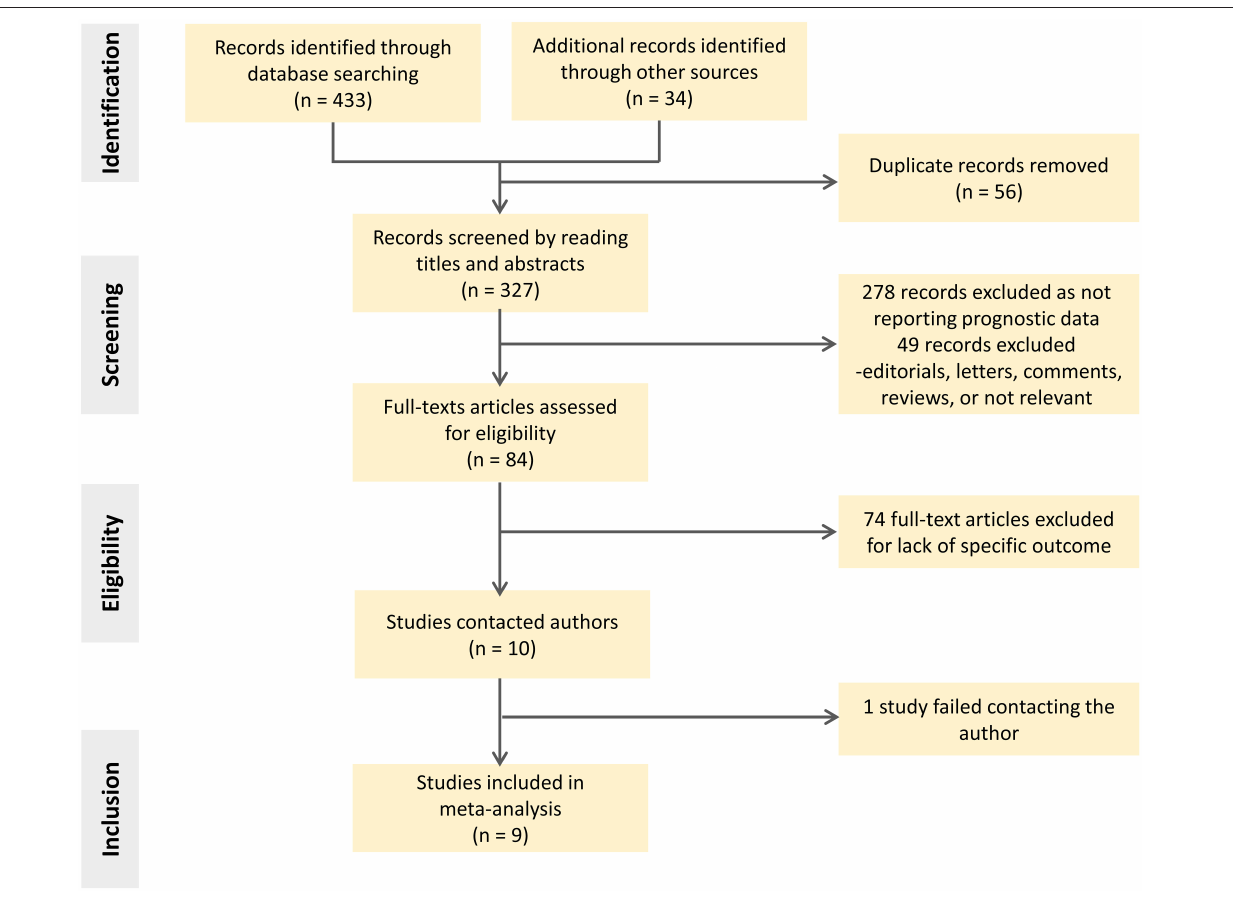
FIGURE 1 | Study search and selection